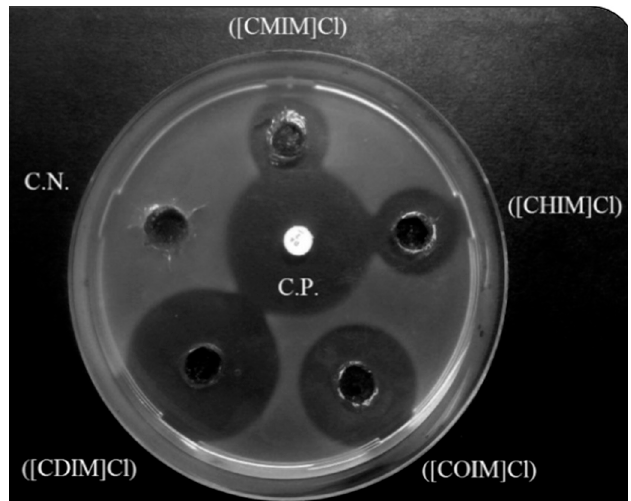
Figure 3. S. aureus growth inhibition halos in the presence of ILs with different chain lengths. C.P. positive control (mupirocin 5 μ g), C.N. negative control.